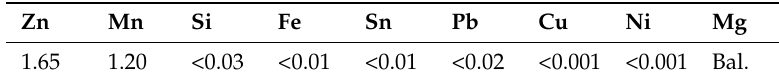
Table 6. Composition of ZM21 [22].